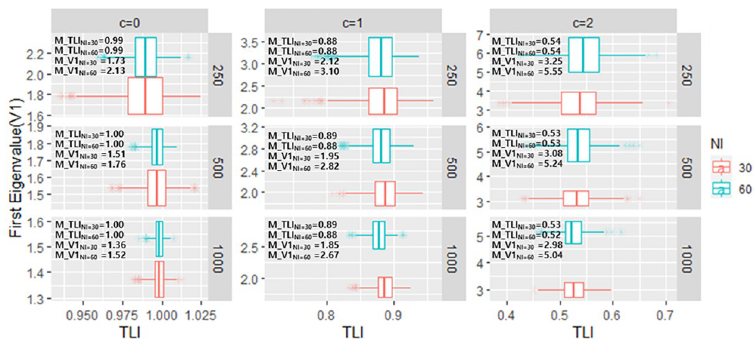
Fig 4. The relationship between first eigenvalue of PCAR and TLI in each TD simulation conditions. ( Note . M: mean of values across